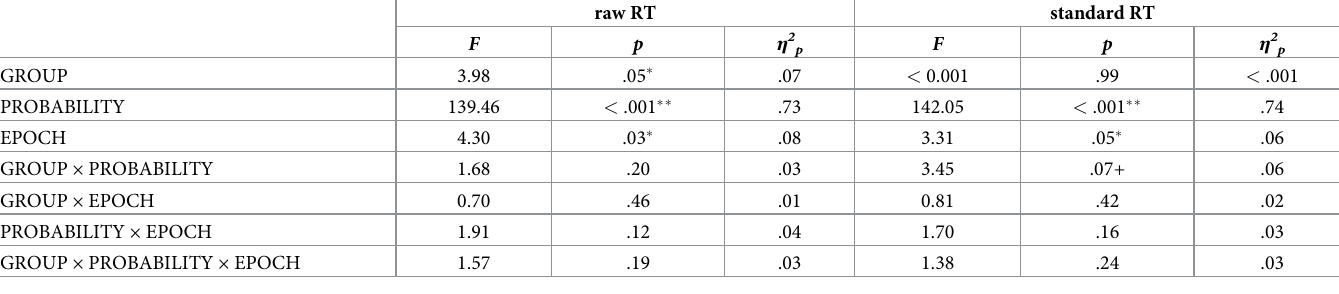
Table 2. Summary of results from ANOVAs performed on raw RT and standard RT data considering learning of probability-based regularities. raw RT standard RT F p η 2 p F p η 2 p GROUP 3.98 .05 � .07 < 0.001 .99 < .001 PROBABILITY 139.46 < .001 �� .73 142.05 < .001 �� .74 EPOCH 4.30 .03 � .08 3.31 .05 � .06 GROUP × PROBABILITY 1.68 .20 .03 3.45 .07 + .06 GROUP × EPOCH 0.70 .46 .01 0.81 .42 .02 PROBABILITY × EPOCH 1.91 .12 .04 1.70 .16 .03 GROUP × PROBABILITY × EPOCH 1.57 .19 .03 1.38 .24 .03 Note. �� p <